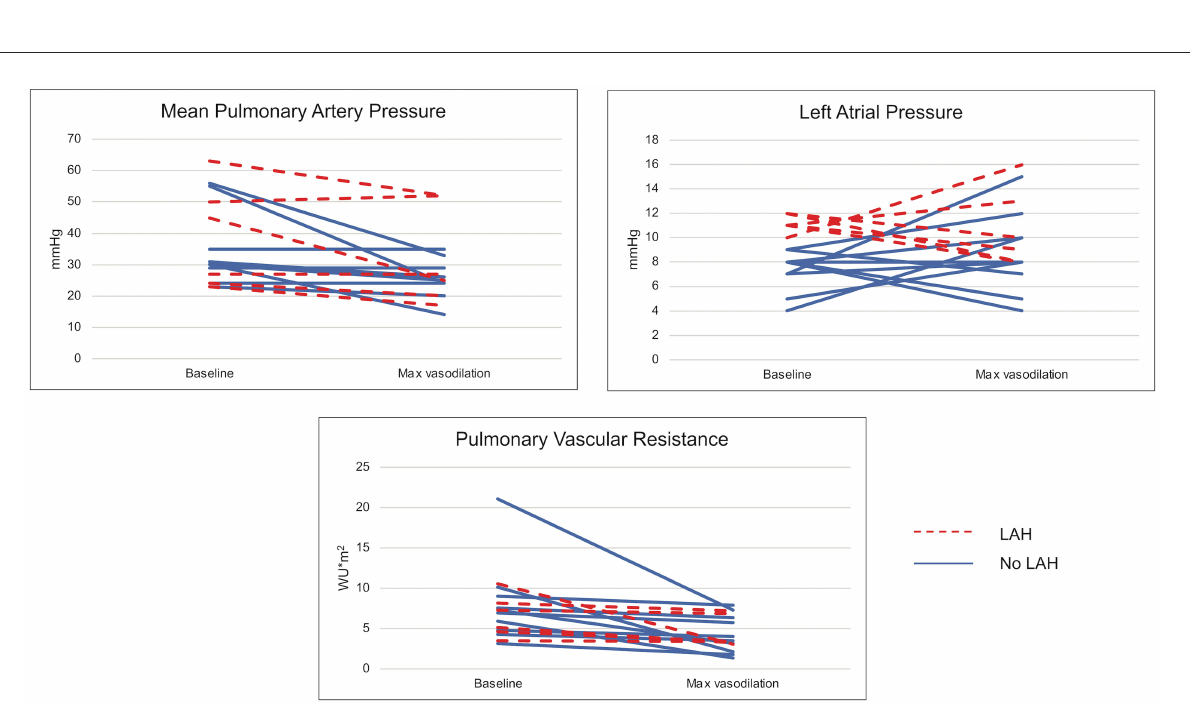
FIGURE2 Hemodynamic changes with acute vasodilator testing. Changes in mean pulmonary artery pressure, left atrial pressure, and pulmonary vascular resistance are demonstrated at baseline and with maximal vasodilation (100% FiO2 ± inhaled nitric oxide) utilized in acute vasodilator testing, which was performed in 16